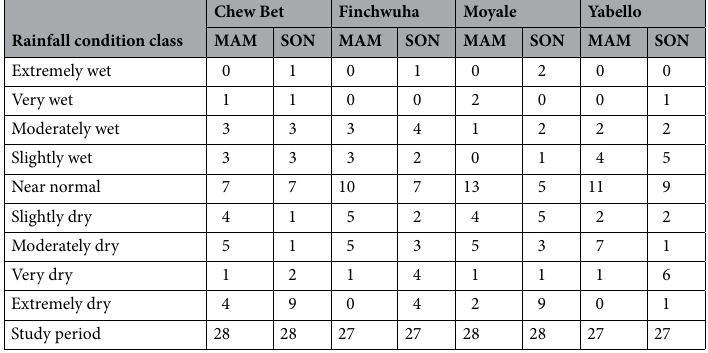
Table 7. Comparisons of seasonal RAI values at selected stations for the 1990–2017 period. Source (Author): Computed based on data from the NMA of Ethiopia.